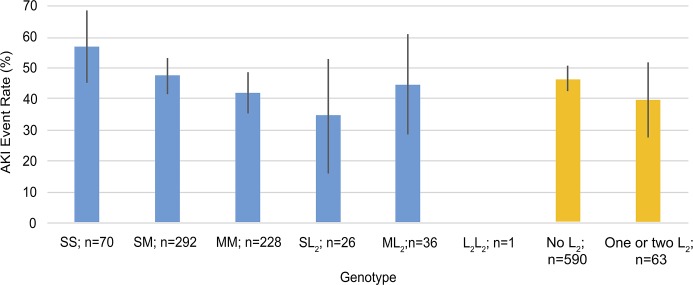
Acute kidney injury (AKI) event rate according to genotype; three-class classification.Allele lengths are: S <27 repeats, 27≤ M <34, L2 ≥34. The blue columns each illustrate the event rate within a genotype, whereas the orange columns illustrate the event rate in all the genotypes without a very long allele in comparison to genotypes with one or more very long alleles.